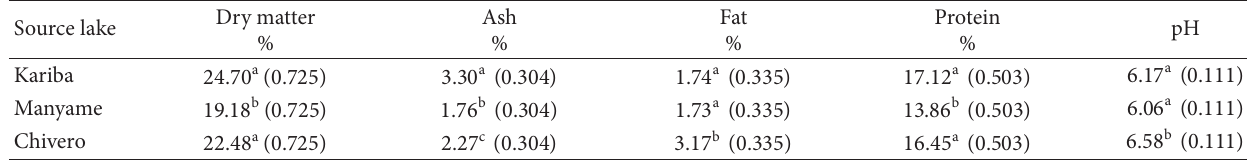
Table 3: Ls mean dry matter, ash, fat, protein, and pH of fish ( s.e. in parentheses ). Source lake